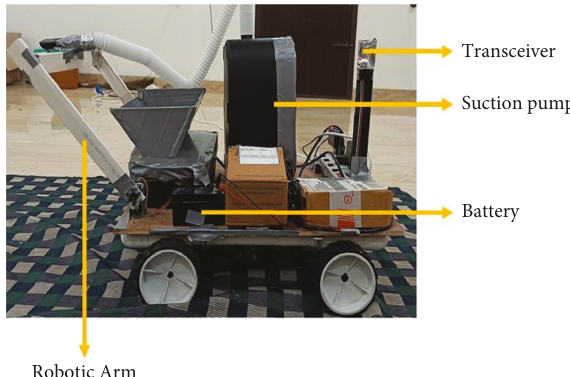
Figure 8: Full view of mobile